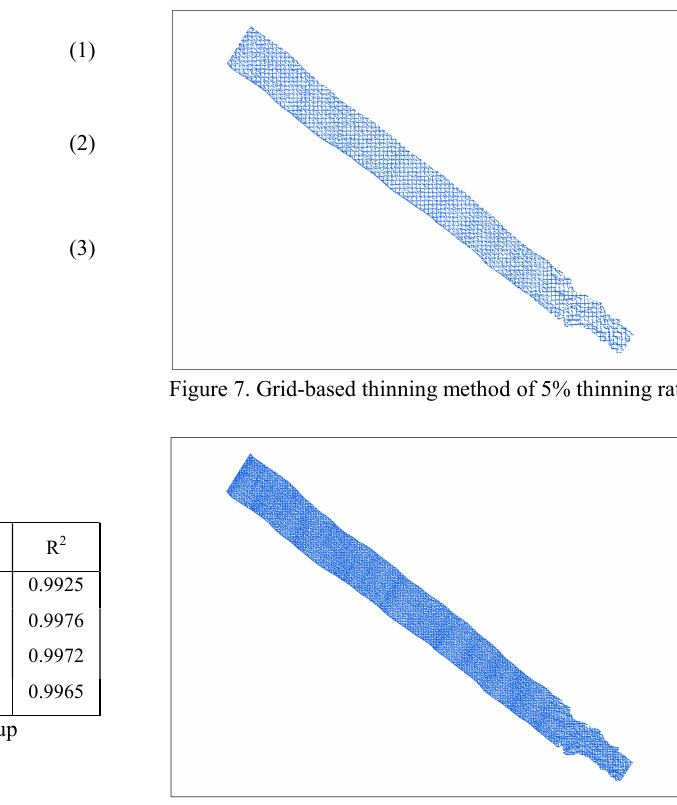
Figure 8. Grid-based thinning method of 11% thinning